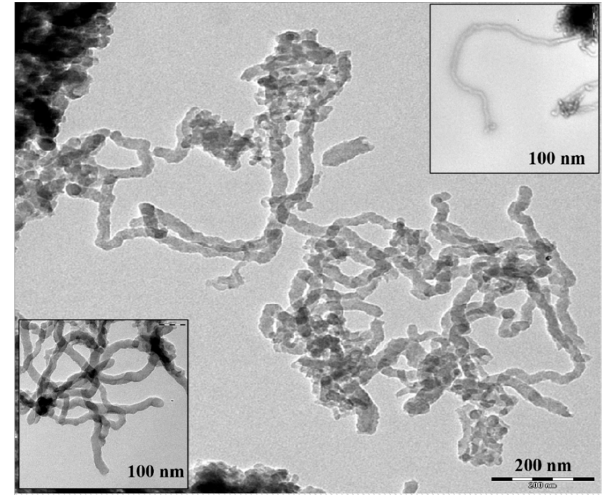
Figure 3. TEM (transmission electron microscope) images for hybrid CNTs.